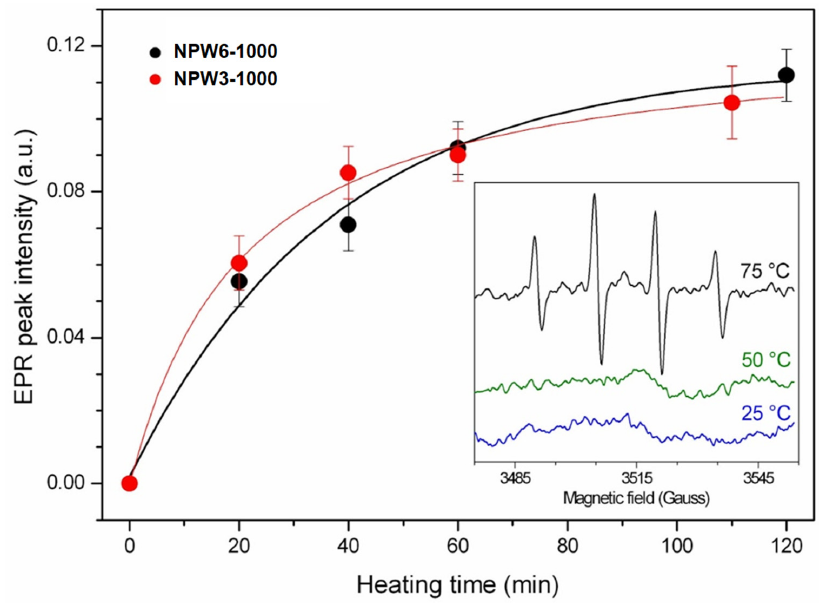
Figure 11. Intensity of DMPO-OH · EPR spectra of NPW3-1000 (red circles) and NPW6-1000 (black circles) at different heating times (inset: EPR spectra obtained with NPW6-1000 after 120 min heating at different temperatures).